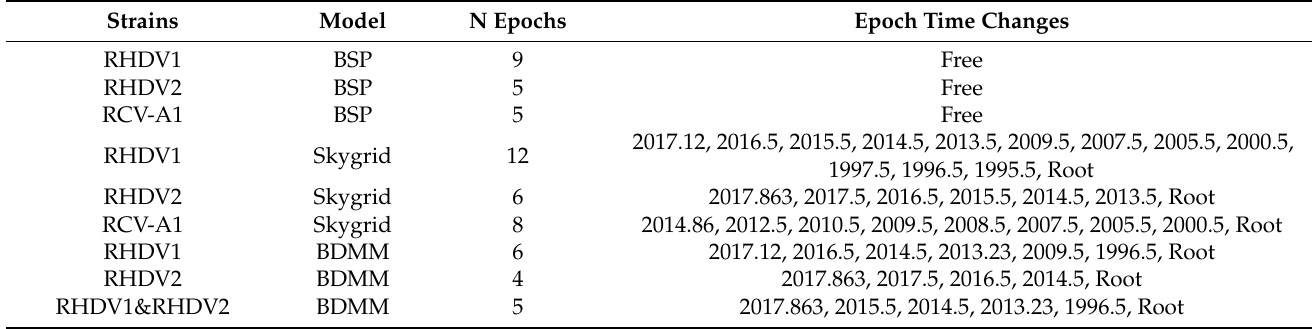
Table 1. Summary of the number of epochs and time changes for each analysis and